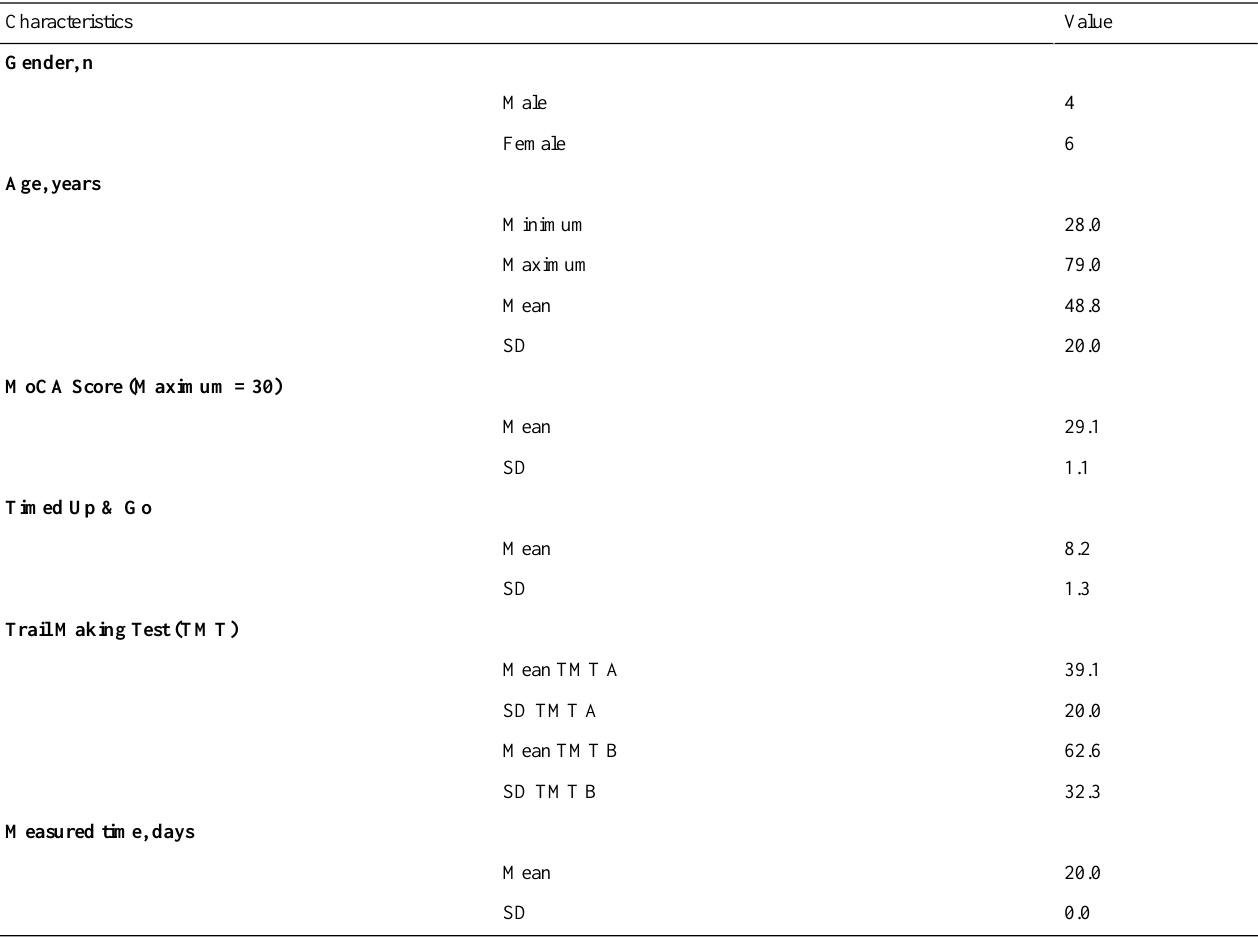
Table 2. Demographics of 10 healthy participants included in the study.